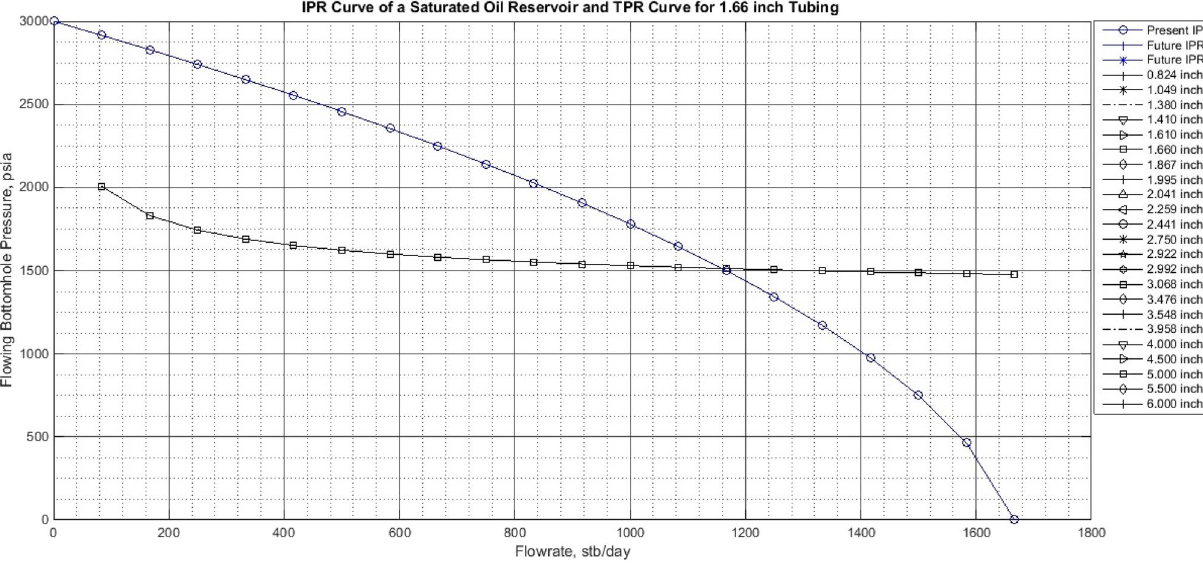
Fig. 8 IPR curve of a saturated oil reservoir and TPR curve for 1.660-inch tubing